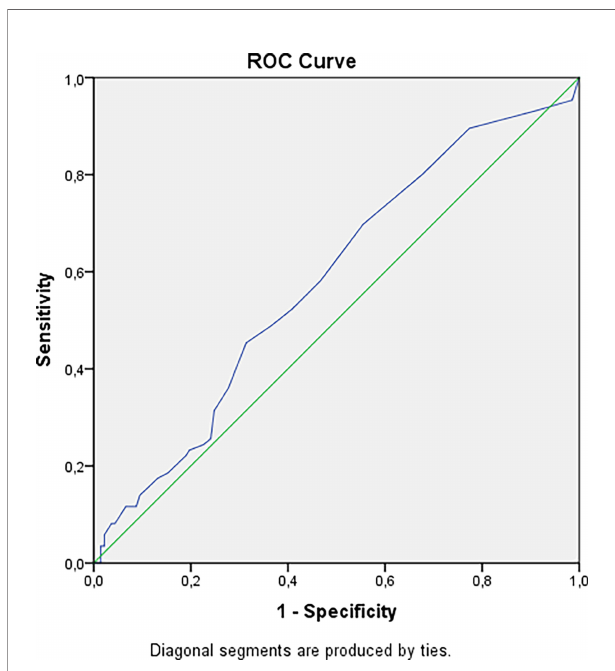
FIGURE 2 | Cut-off point for developing nephrolithiasis/nephrocalcinosis in patients with hypoparathyroidism. AUC=0.582 (95% CI: 0.505; 0.658), р =0.040. Cut-off point – 4.5 years. Sensitivity = 70% (95% CI: 61%; 78%). Speci fi city = 45% (95% CI: 39%; 50%). PPV = 44% (95% CI: 39%; 49%). NPV = 70% (95% CI: 62%; 78%). OR = 1.85 (95% CI: 1.05;